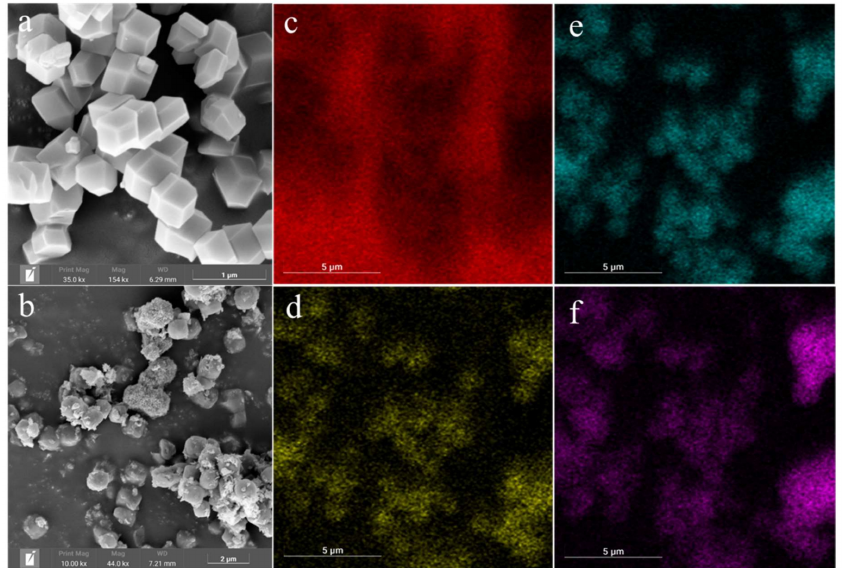
Figure 2. SEM images of ZIF-8 ( a ) and Cu-ZIF-8-1 ( b ); EDS mappings of the selected areas in Cu-ZIF-8-1: distribution of C ( c ), N ( d ), Zn ( e ), and Cu ( f